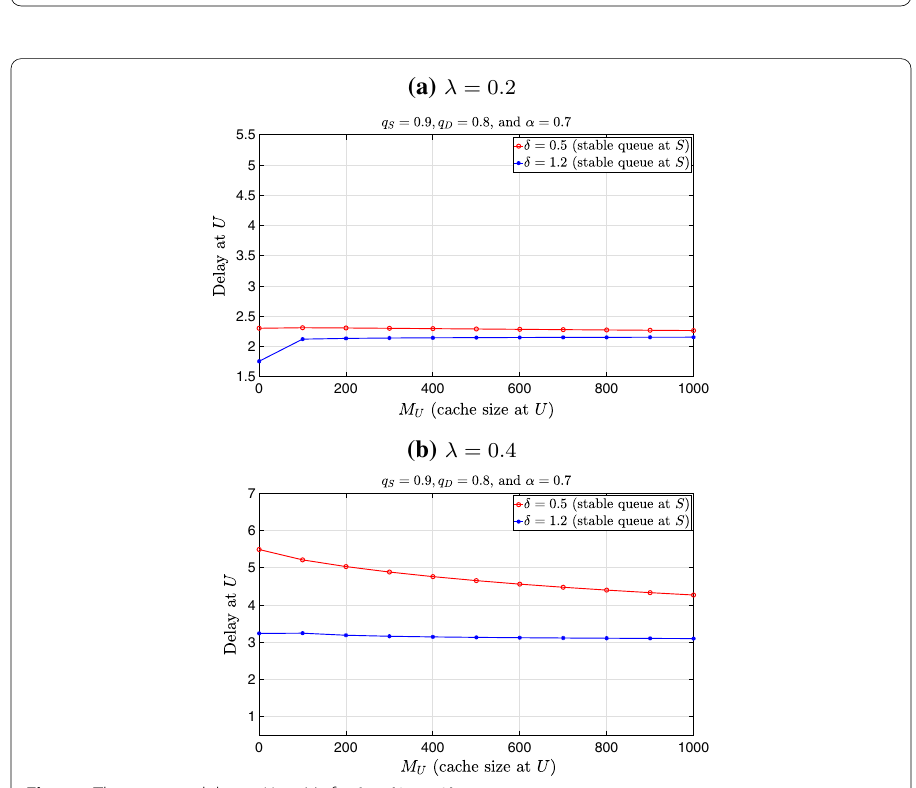
Fig. 14 The average delay at U vs. M U for δ ∈ { 0.5,1.2